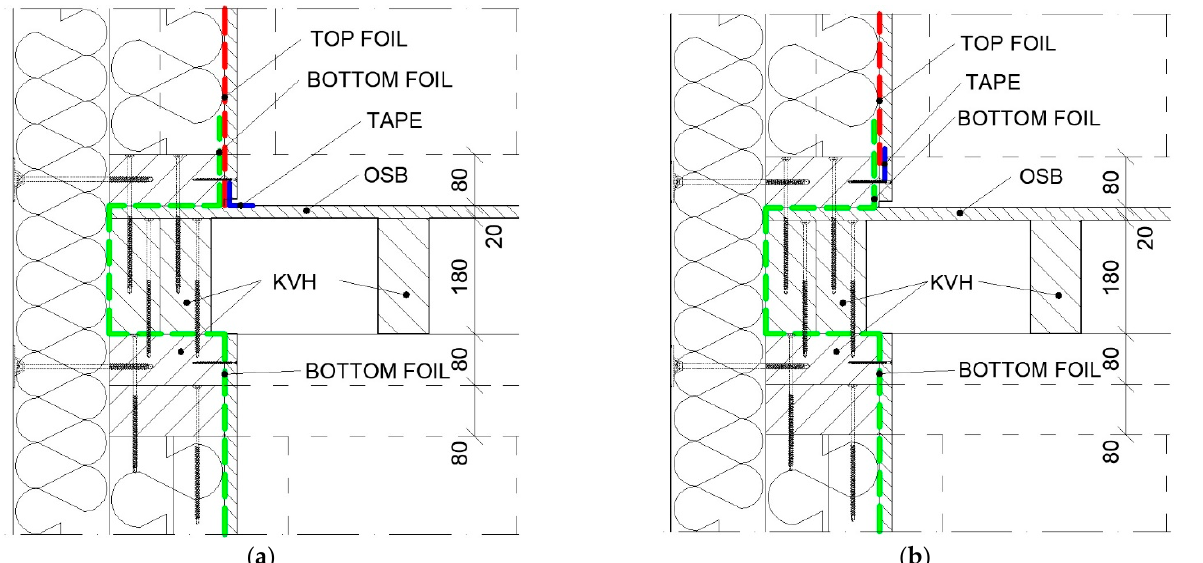
Figure 9. Connection of the vapor-barrier foil—variant 1, variant 2: ( a ) 1st variant; ( b ) 2nd